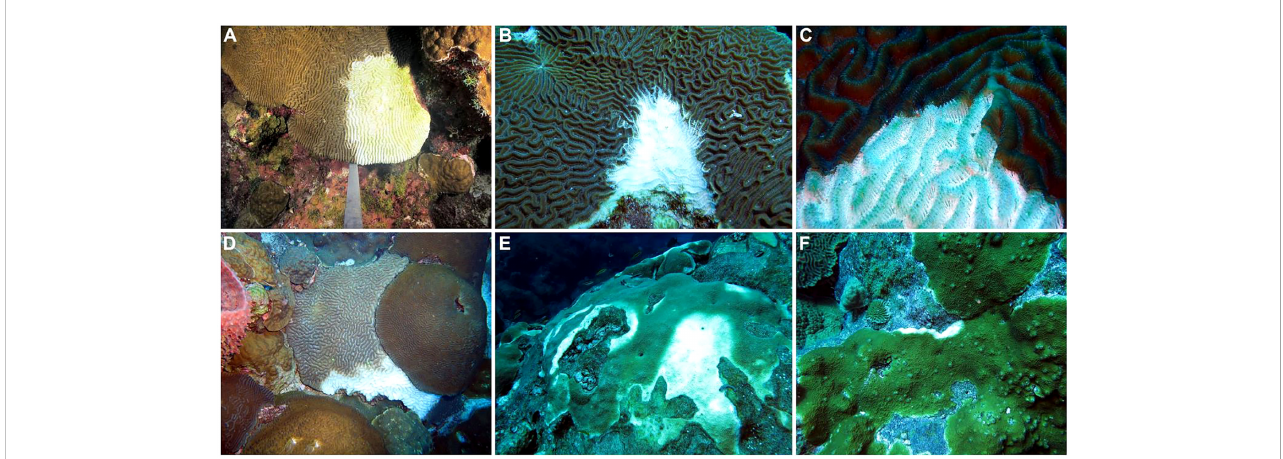
FIGURE 2 Examples of disease lesions on primary reef-building coral species from Flower Garden Banks (northwest Gulf of Mexico). (A) Focal lesion starting from the margin of a Pseudodiploria strigosa colony, (B) focal lesion on P. strigosa colony with evidence of skeletal damage due to predation (bottom), (C) rapid tissue loss and necrosis at the lesion front on P. strigosa colony, (D) active lesion spreading across Colpophyllia natans colony, (E) multifocal infection on Orbicella faveolata colony, (F) focal lesion beginning on Orbicella franksi